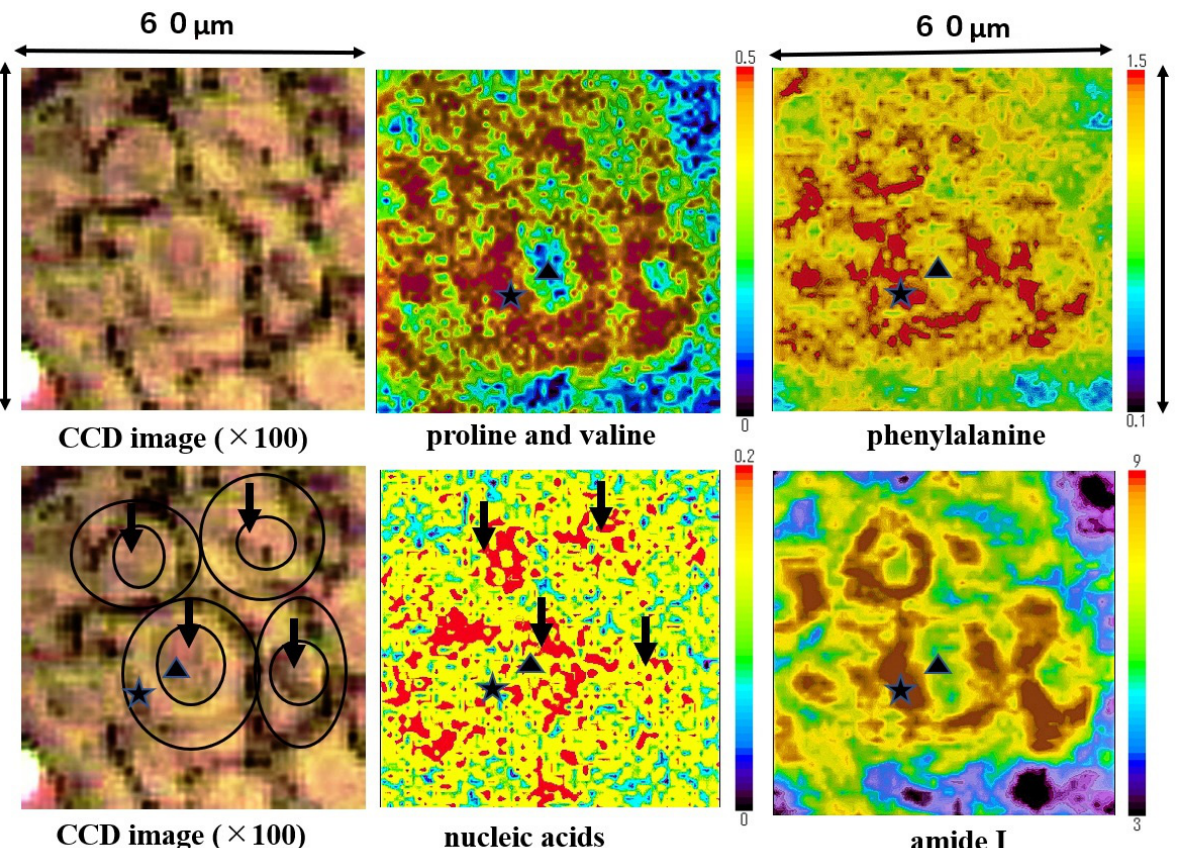
Figure 6. The mapping images proline and valine, phenylalanine, nucleic acids, and Amide I in the four-sided area of Figure 4 are shown. Proline and valine, phenylalanine, and amide I were detected mainly in the cytoplasm of SCC cells. In each image ▲ and ★ indicate the nucleus and ★ the cytoplasm individually, position of ▲ and ★ are all same. Table 1. Peak position of amide I in the SCC and normal areas, and in the nuclei and cytoplasm of SCC cells. Sample numbers and measurement points are